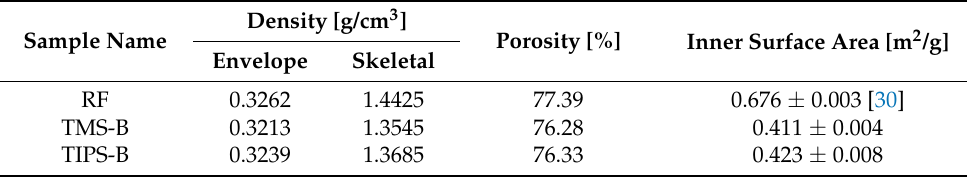
5 of 12 Figure 3. SEM-EDX overlay image and single images of elemental distribution within a TIPS- functionalized RF xerogel.